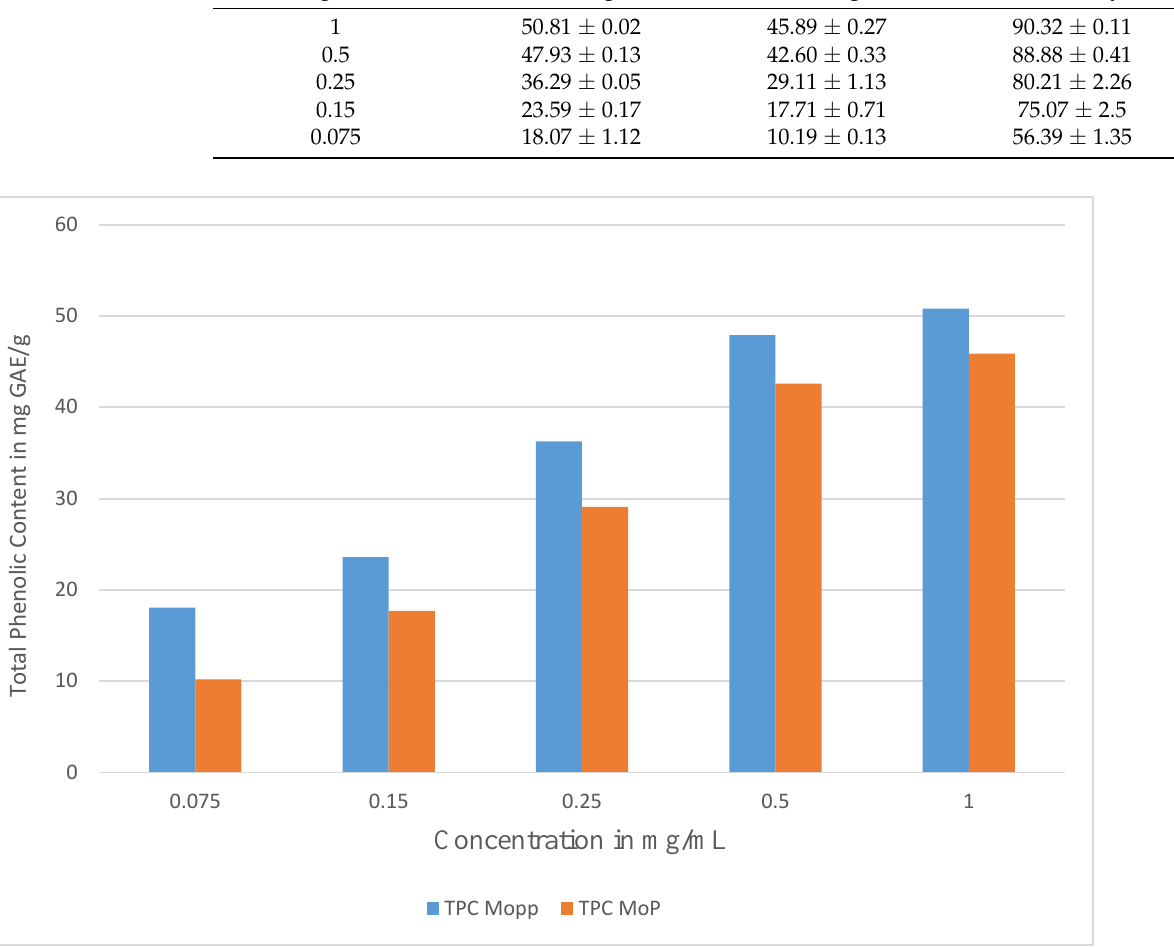
Figure 2. The total phenolic content of Mopp before and after MoP complex formulation. Table 1. Total phenolic content and the encapsulated efficiency.